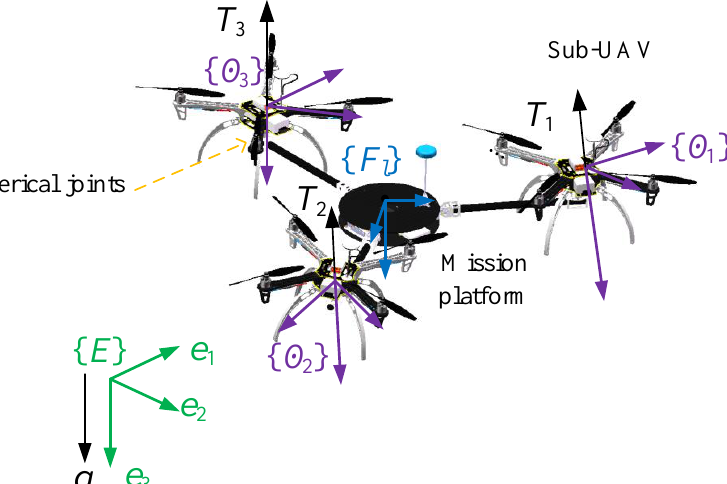
Figure 1. Schematic of an IAP with three